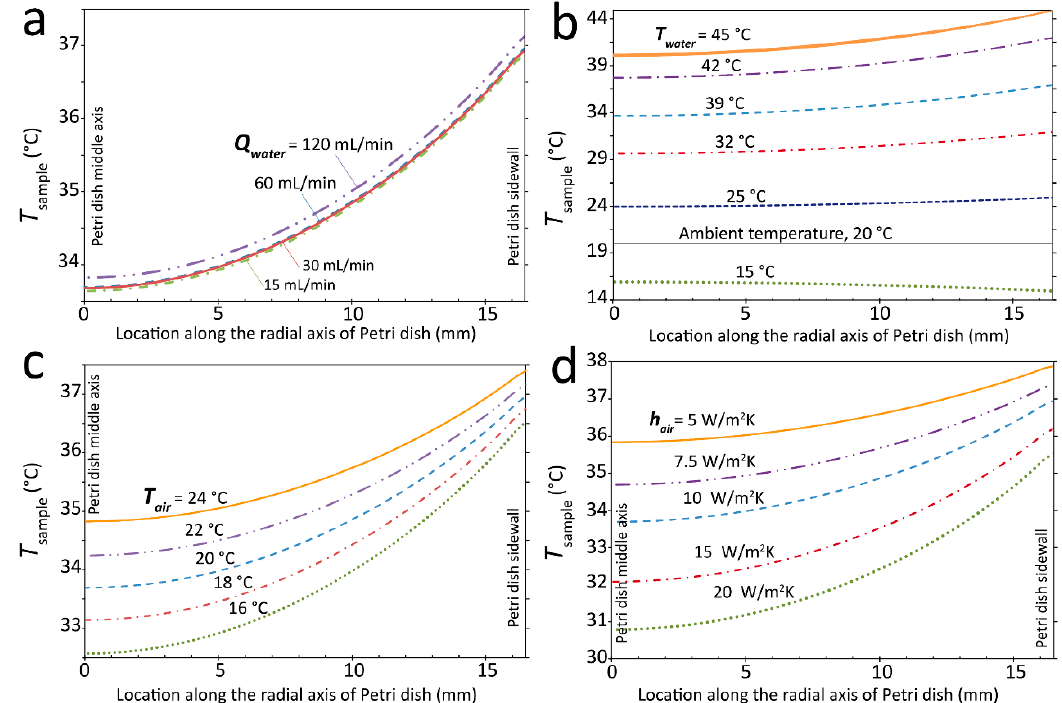
Figure 3. Numerical characterization of the temperature profile along the bottom surface of the Petri